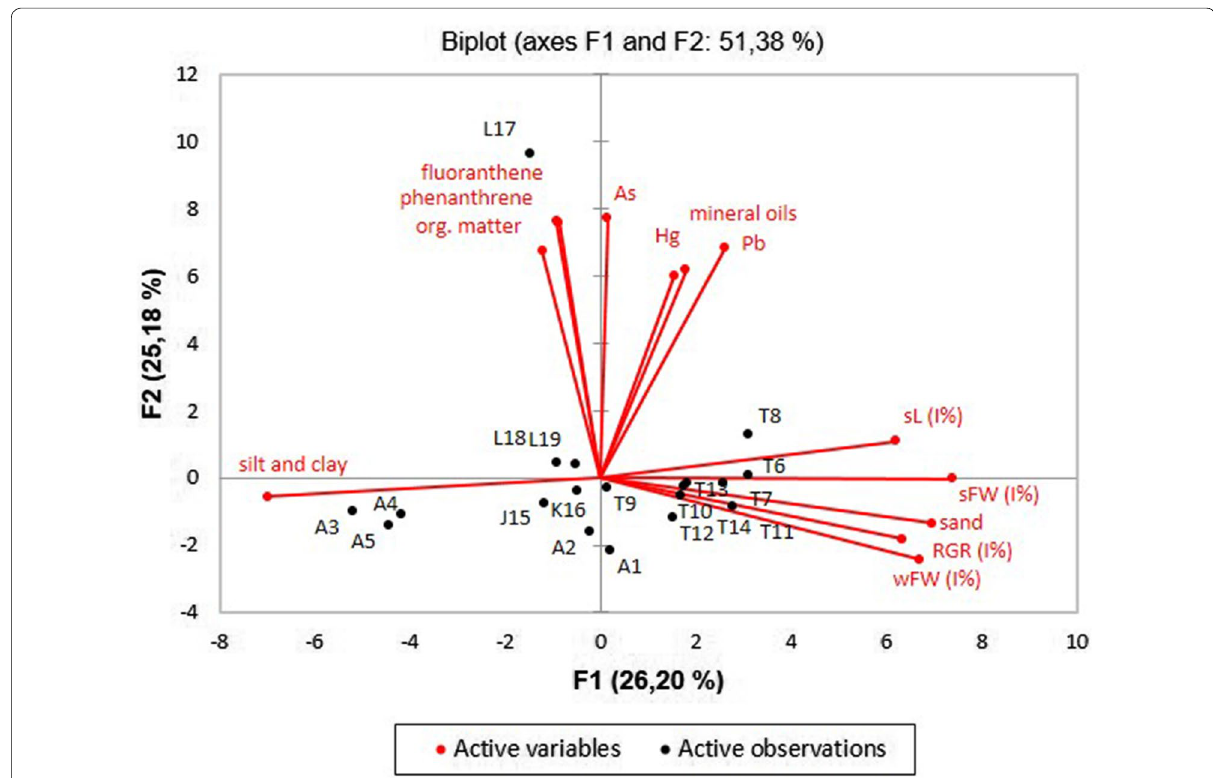
Fig. 2 PCA based on M. aquaticum growth responses and physico–chemical parameters in sediments (Inhibitions based on RGR (I%)—relative growth rate, wFW (I%)—whorl fresh weight, sFW (I%)—shoot fresh weight, sL (I%)—shoot length, rFW (I%)—root fresh weight; A1–5: artificial sediments with different organic matter, sand and fine particle content. Natural samples: T6–14 Tamiš; J15 Jegrička; K16 Krivaja; L17–19